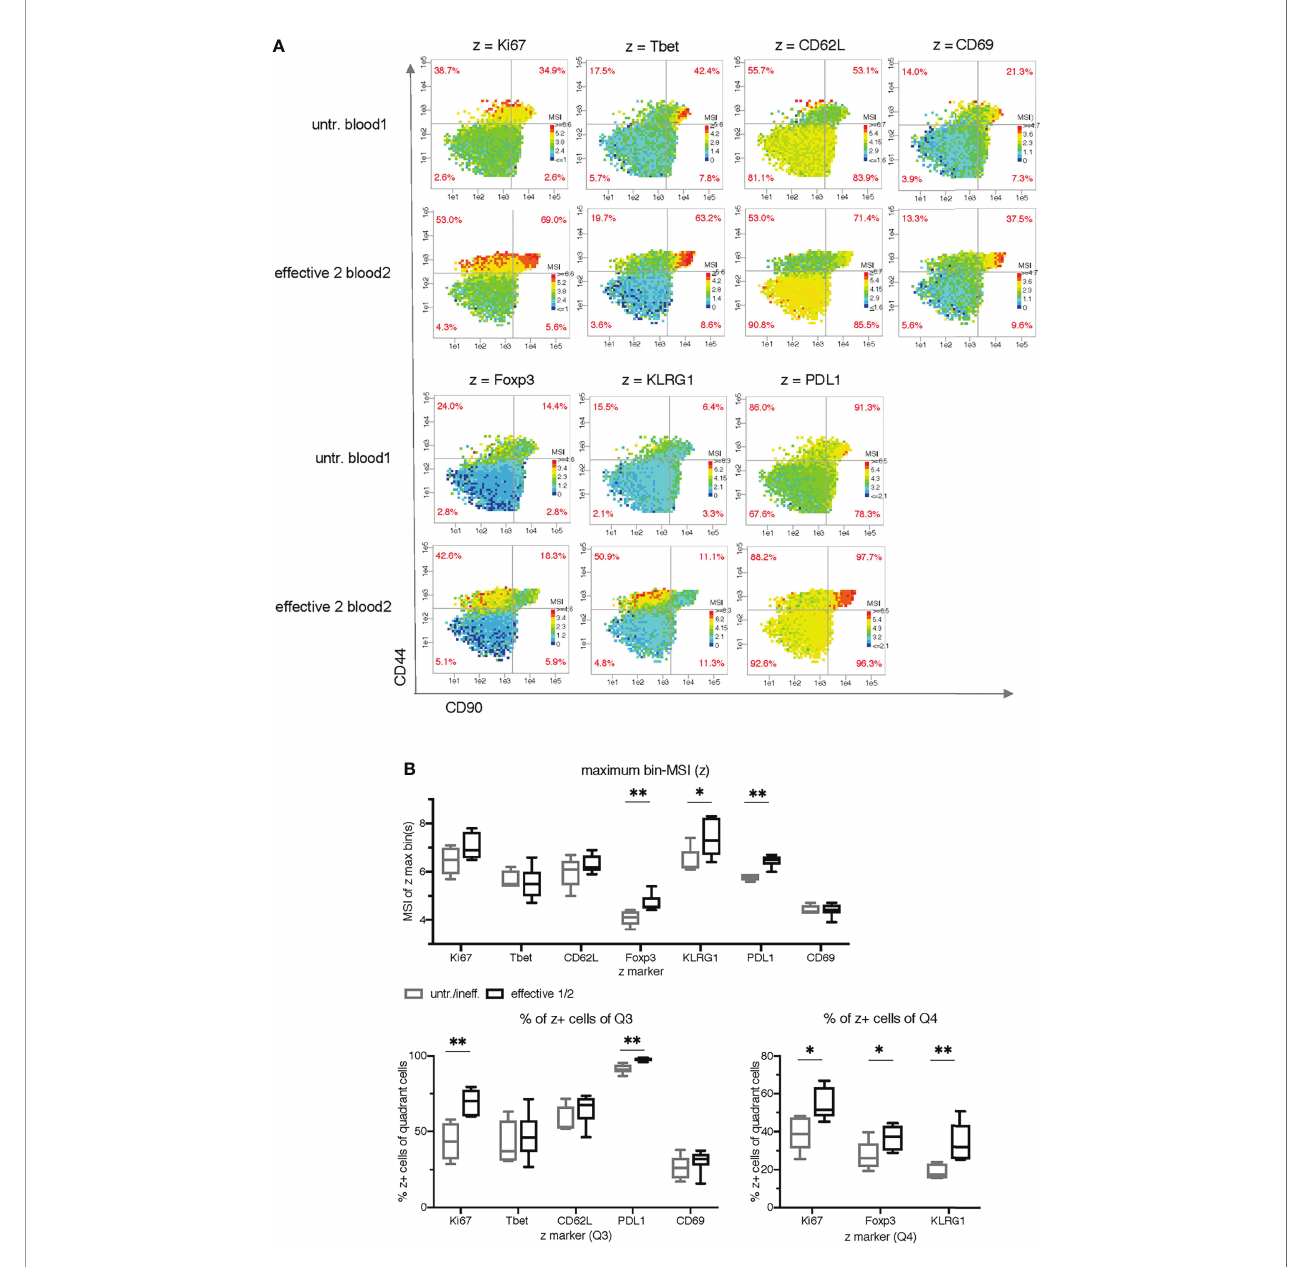
FIGURE 4 | Cell subset characterization using side by side plots and common ranges for each z-parameter. (A) Comparison of mean signal intensity (MSI)-bin patterns of two exemplary samples (untreated blood1 and effective 2 blood2) for seven z parameters using common intensity ranges for z (min-max of both samples). (B) Statistical comparison of the maximum bin-MSI values per sample (PRI-analysis) and the frequencies of the quadrant cells in Q3 and Q4 (red quadrant numbers of the MSI-bin plots) of all 11 samples for seven z parameters. The ineffective treatment group with untreated (untr.) and ineffectively treated (ineff.) samples is shown in gray and the effective treatment group with effective treatment 1 and 2 in black. P < 0.05 was considered signi fi cant, with the numbers of asterisks indicating: *p ≤ 0.05; **p ≤